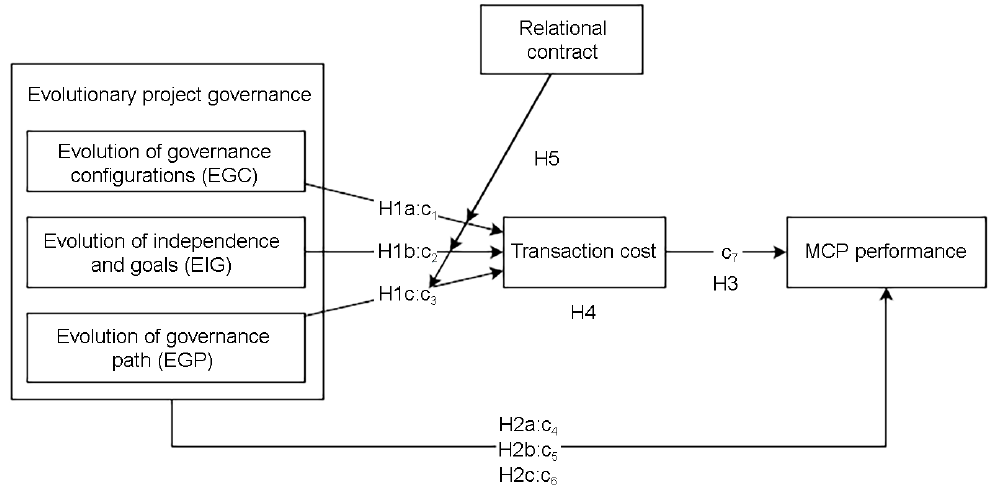
Figure 1. Research model and